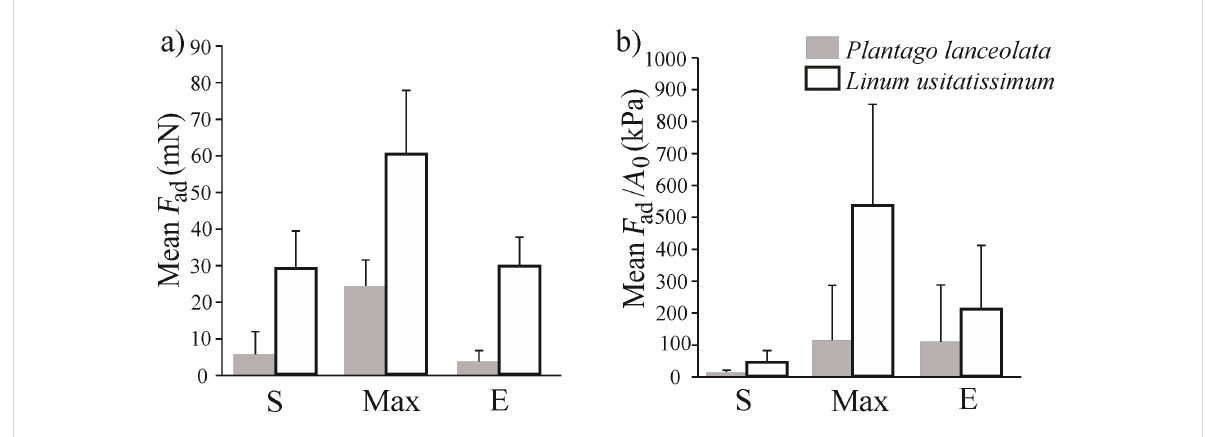
Figure 6: The comparison of the mean values of F ad (adhesion force) and F ad / A 0 (adhesion stress) at different desiccation conditions for Plantago lanceolata and Linum usitatissimum . S – at the beginning of the experiment, when the mucilage envelope contains water, Max – maximal value (when the mucilage envelope probably lost the most amount of water), E – at the end of the measurements (when the mucilage almost dried out).